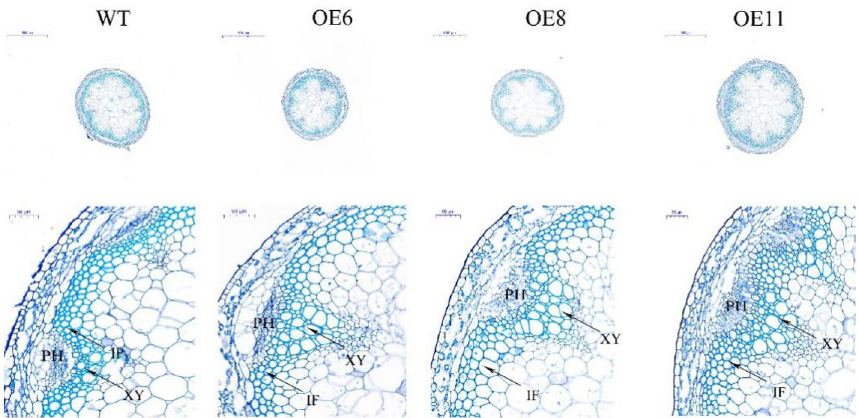
Figure 6. Sections stained with toluidine blue, showing the variation of cell walls in Arabidopsis with PbCSE1 overexpression. PH phloem, XY xylem, IF interfascicular fiber.